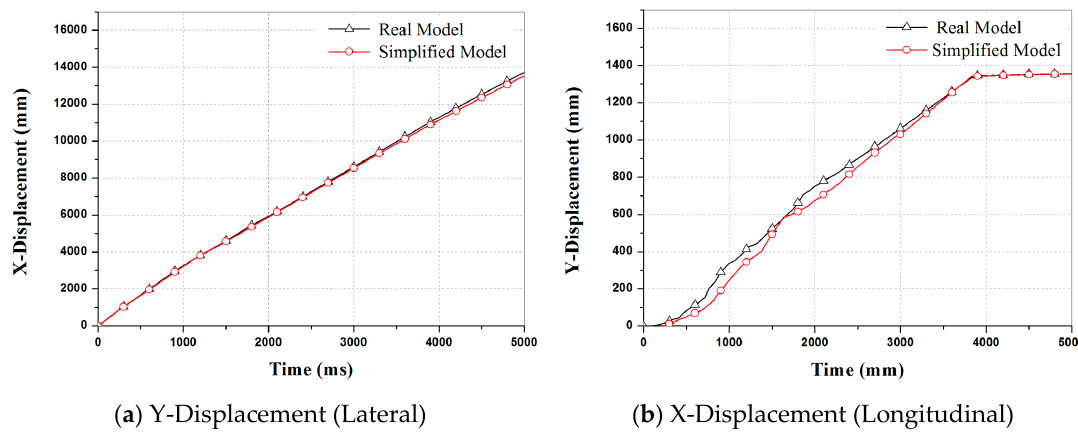
Figure 8. The comparison of results between the real and simplified models in simulation.